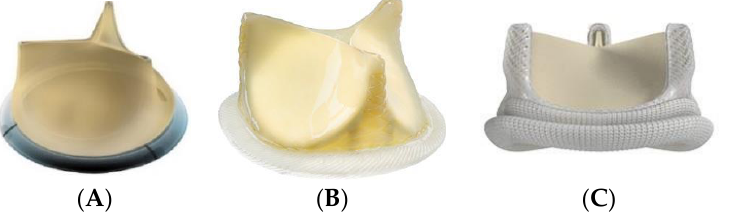
Figure 1. Pericardial aortic bioprostheses. Crown PRT TM . LivaNova ( A ); Trifecta TM . Abbott ( B ); Carpentier Perimount Magna Ease TM . Edwards Lifesciences ( C ). Carpentier Perimount Magna Ease TM . Edwards Lifesciences ( C